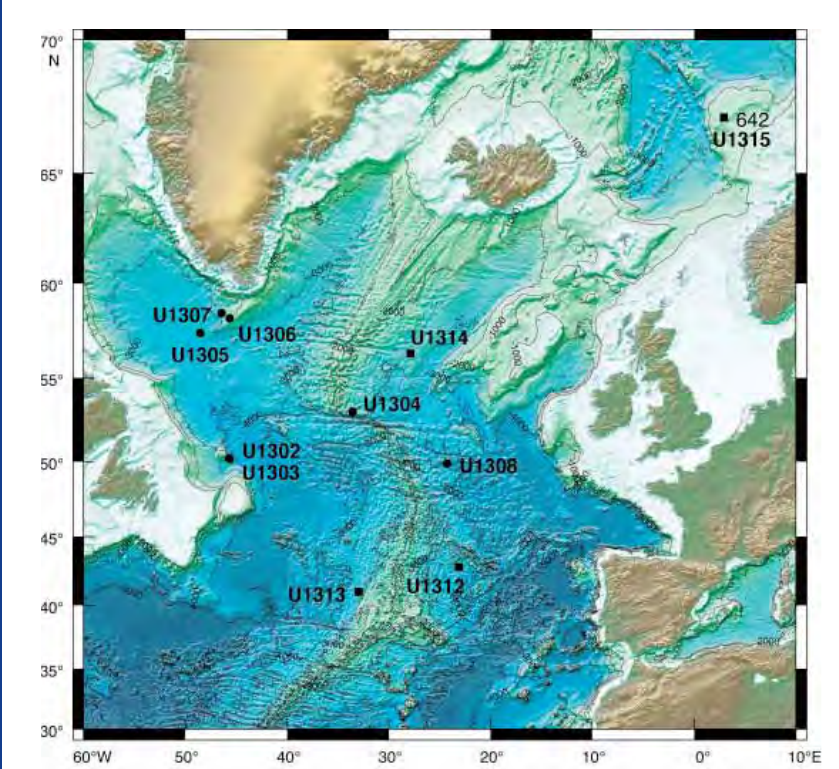
Figure 1. Location of sites occupied during IODP Expedition 303 (Sites U1302–U1308, September–November 2004), and Expedition 306 (Sites U1312–U1315, March–April